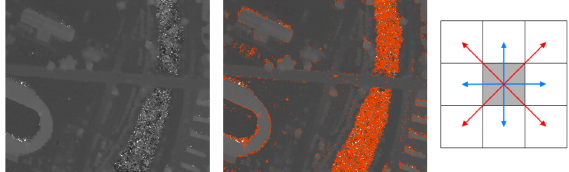
Figure 8. Left: 3D disturbed areas. Right: disturbed area profile.